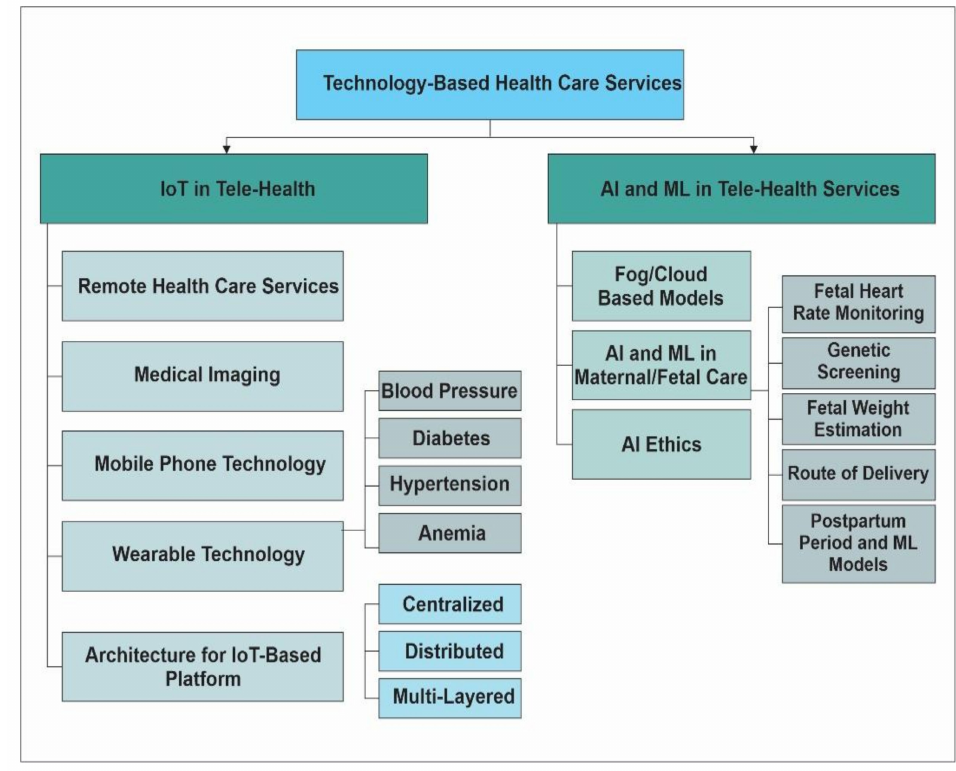
Figure 1. General classification of healthcare